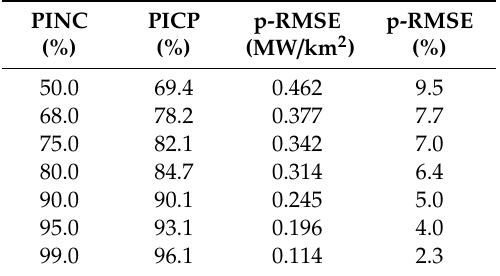
Table 4. PICP (across the forecasting horizon) and p-RMSE (for year 2019). PINC PICP (%) (%)